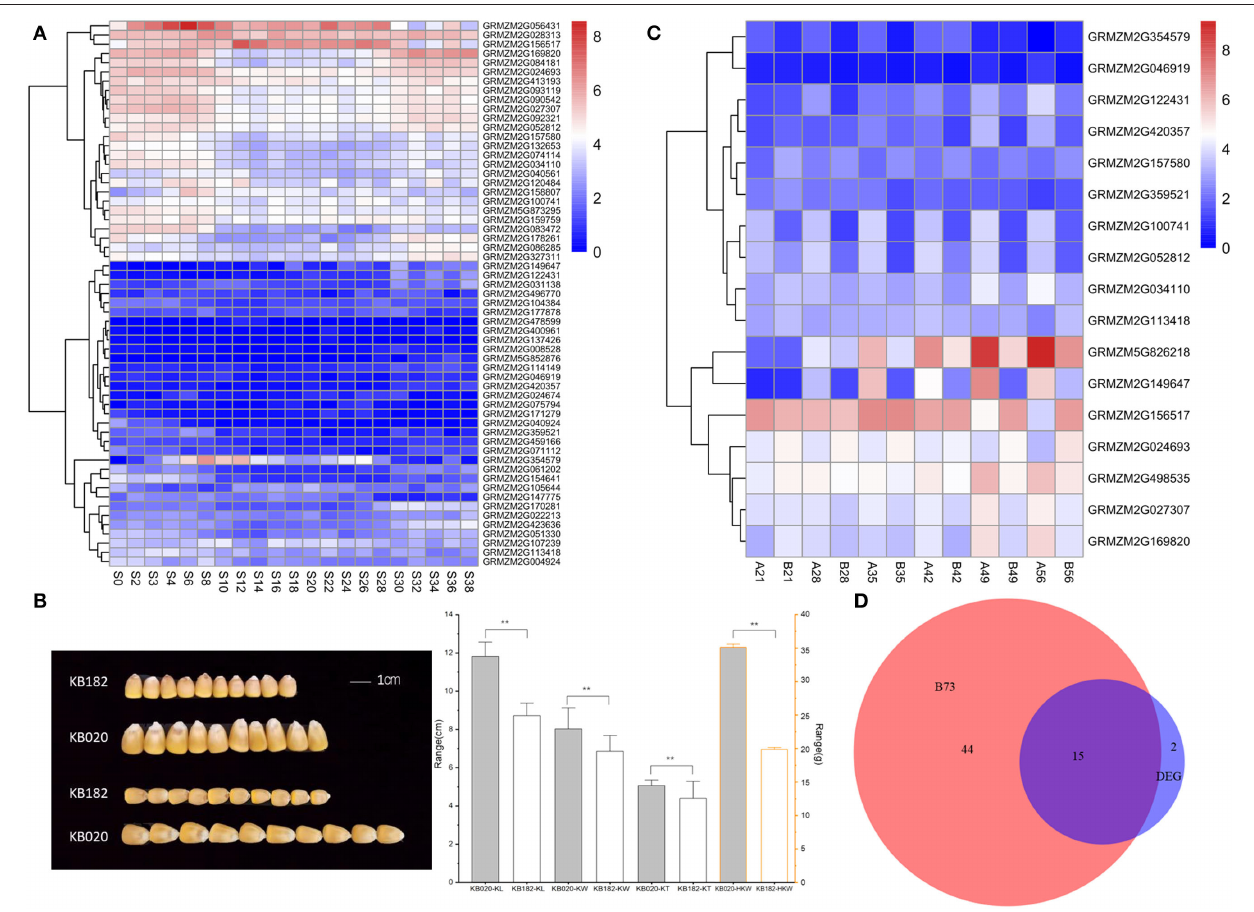
FIGURE 3 | Expression profile of the candidate genes and phenotype of KB182 and KB020. (A) Dynamic expression patterns of candidate genes related to four traits in B73 during kernel development. S denotes days after pollination for the seed. (B) Kernel images of maize inbred lines KB182 and KB020. Ten seeds each was taken and bar graph of the distribution of three kernel-related traits in KB182 and KB020. The Vernier caliper was used to measure 20 kernels with uniform size. KL, kernel length; KW, kernel width; KT, kernel thickness. **Indicates significance at the level of P < 0.01. The data range of KL, KW, and KT is the scale of the left axis. The data range of HKW is the scale of the right axis. (C) Dynamic map of kernel development of candidate genes determined using significant SNPs with different genotypes in maize inbred lines KB182 (small kernel) and KB020 (big kernel). In the ordinate, A represents KB182, B represents KB020, and the number represents the days after pollination. (D) Common identified genes in B73 and the comparison of KB182 and KB020. The scale bars indicate the relative expression levels of genes. B73 represents the number of genes in (A) / DEG represents the number of genes in (C) .